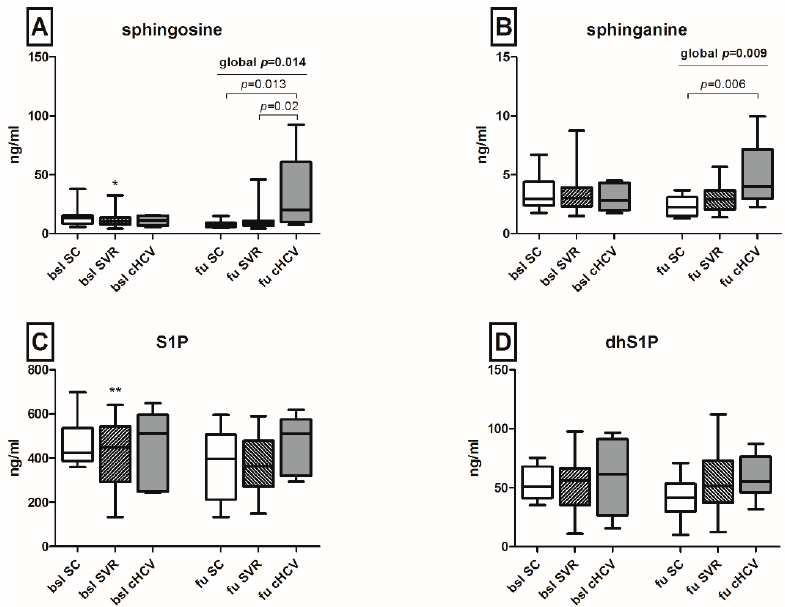
Figure 4. Sphingosine, sphinganine and their phosphate derivatives during acute HCV infection. Sphingosine levels on follow-up were significantly upregulated in patients unable to clear HCV compared both to patients with spontaneous or subsequent therapy-induced resolution of HCV infection (( A ), p = 0.02 and p = 0.013, respectively). Sphinganine levels were significantly elevated upon chronification of HCV infection on follow-up (( B ), p = 0.006), while patients with subsequent SVR after antiviral treatment showed a significant longitudinal reduction of S1P levels (( C ), ** p < 0.01). No significant difference in dhS1P levels was observed ( D ). Statistical significance between baseline and follow-up is indicated by asterisks (*). S1P: sphingosine 1 phosphate; dh: dihydro; SC: spontaneous clearance; SVR: sustained viral response; BSL: baseline; FU: follow-up; cHCV: chronic HCV.